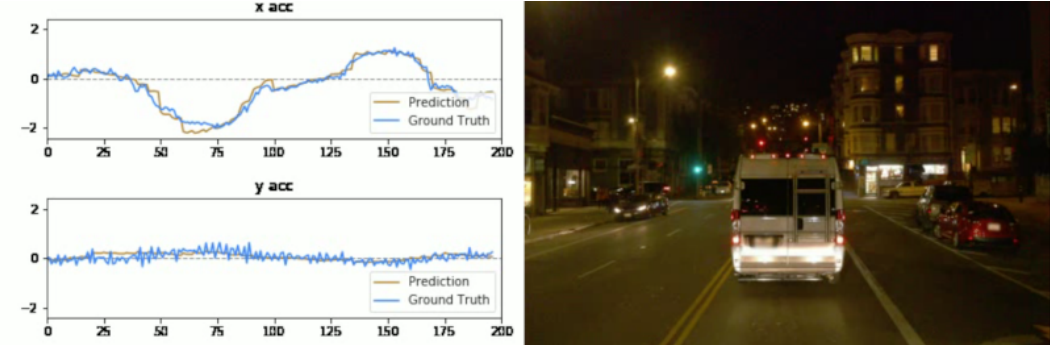
Figure 8. Model prediction with synchronized frames captured by the front-camera on the